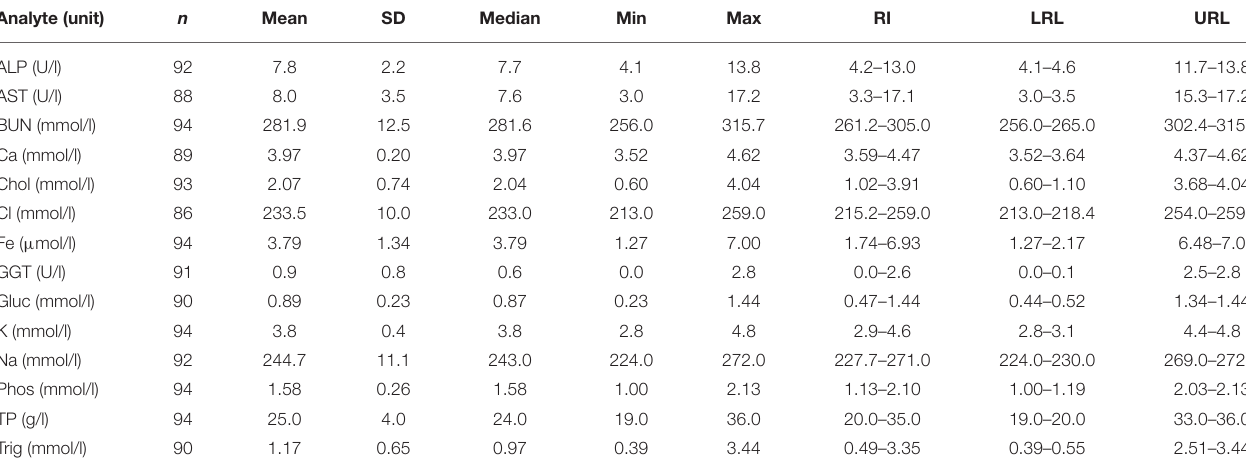
TABLE 3 | Blood chemistry reference intervals for Nursehound Sharks ( Scyliorhinus stellaris ) under human care. Analyte